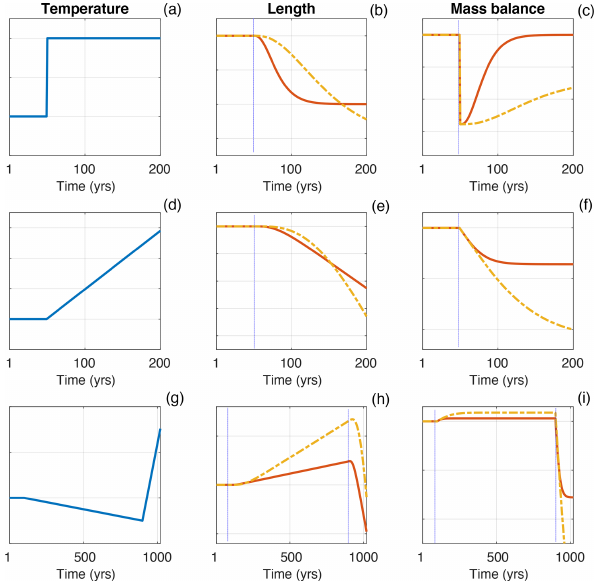
Figure 1. An illustration of three simple climate scenarios (a, d, g) and the response of glacier length (b, e, h) and mass balance (c, f, i) , for two glacier response times: τ = 20 years (red lines) and τ = 60 years (dashed orange line). The magnitudes of the changes are essentially arbitrary in these examples but serve to illustrate the basic principles of the